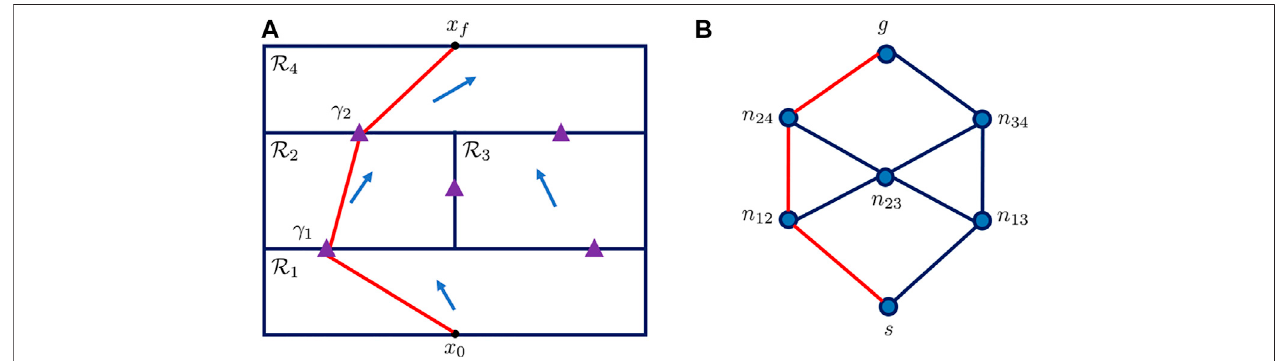
FIGURE 1 | (A) Partitioned cells in the domain. On each boundary of two adjacent cells there is a candidate junction point, represented as the purple triangle (B) Graph representation of the workspace. The vertices represent the candidate junctions, while the edges are the path segment between the adjacent junctions. The red line on both of the plots represent the same example